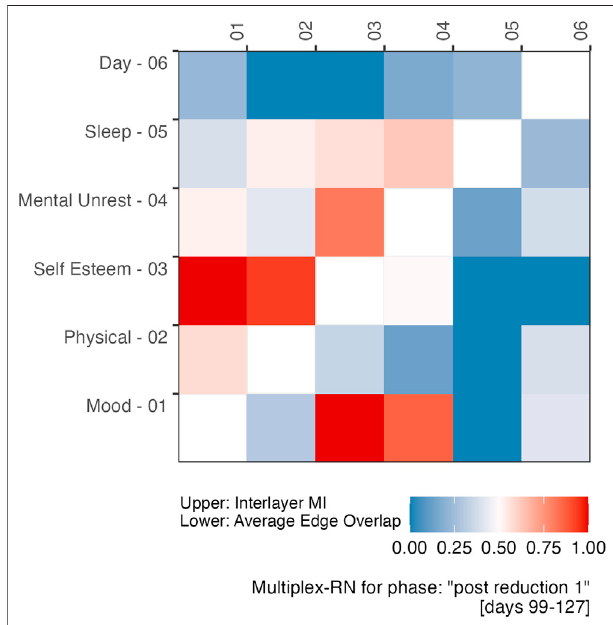
FIGURE 8 | An example of a distance matrix from which a Multiplex Recurrence Network can be constructed. The upper triangle is based on the Inter-layer Mutual Information, the lower triangle represents the Average Edge Overlap between network layers. The values were transformed to the unit scale, using the maxima and minima observed during the post reduction